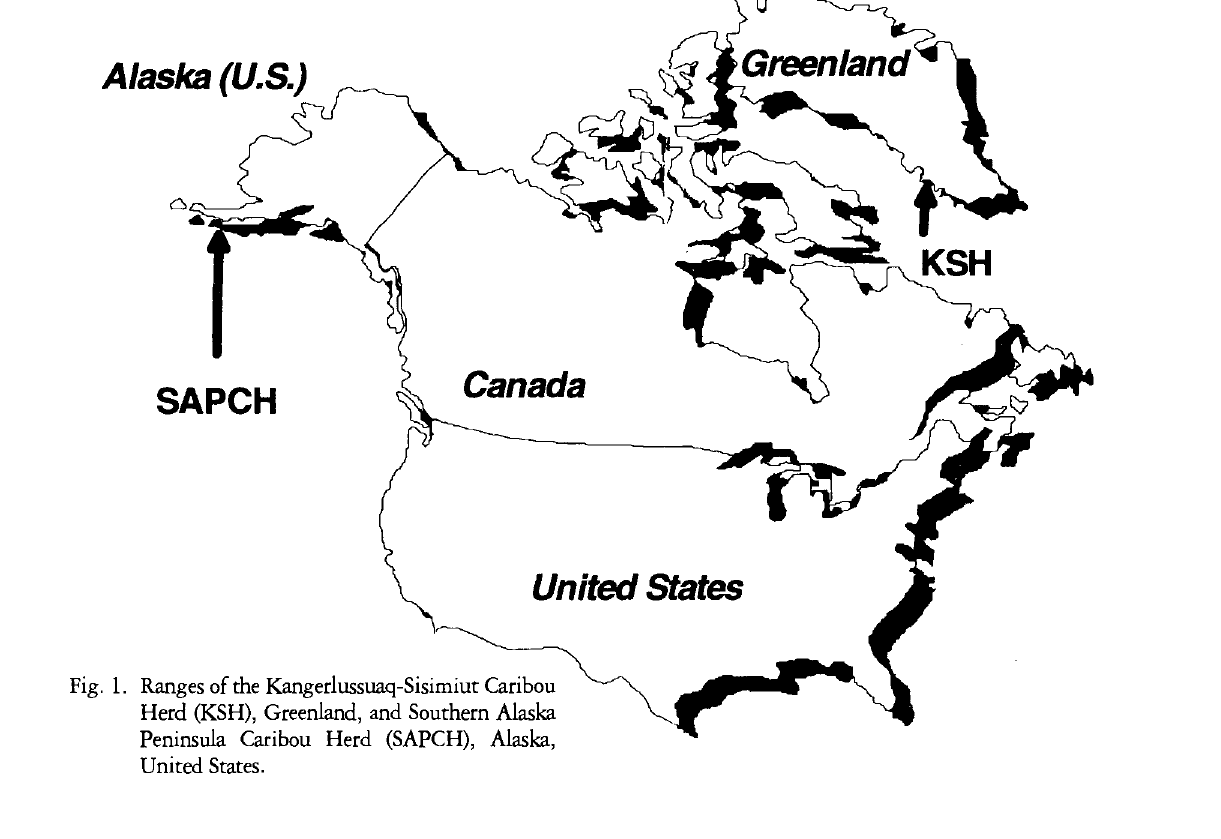
Fig. 1. Ranges of the Kangerlussuaq-Sisimiut Caribou Herd (KSH), Greenland, and Southern Alaska Peninsula Caribou Herd (SAPCH), Alaska, United